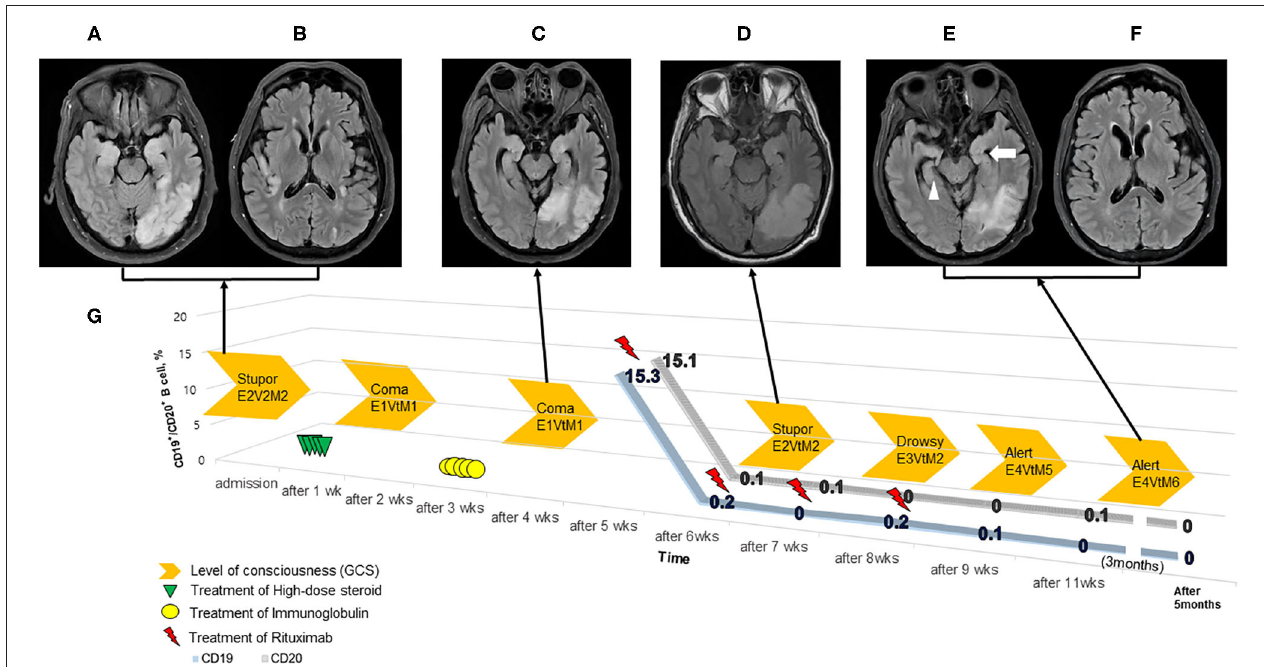
FIGURE 1 | Timeline of the patient treatment. (A–F) Brain MRI (T2-FLAIR) demonstrates autoimmune encephalitis. The patient’s level of consciousness (orange arrows, GCS) improved following treatment with high dose steroid (green triangle), intravenous immunoglobulin (yellow circle), and rituximab (red thunderbolt) (G) . The CD19 + /CD20 + B-cell counts were present during the 5-week to 5-month follow-up after admission. There was the depletion of CD19 + /CD20 + B-cell counts within 1 week after an initial infusion of